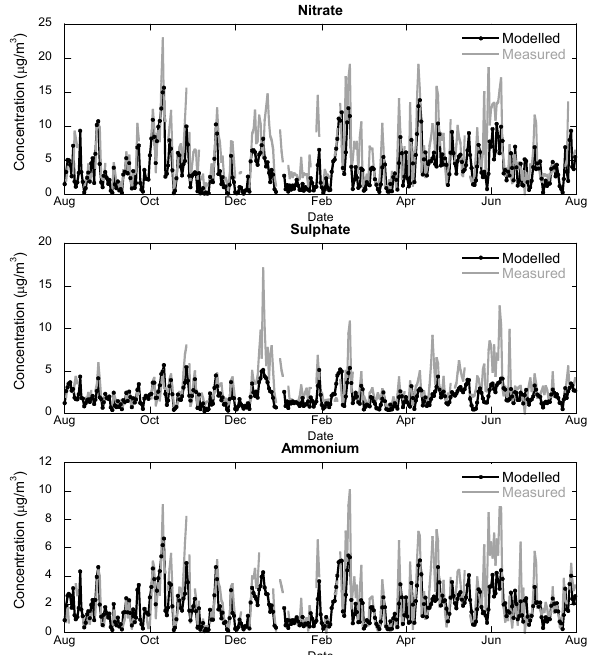
Fig. 4. Comparison of the measured (grey) hourly concentrations of Figure 4. Comparison of the measured (grey) hourly concentrations of nitrate and sulphate at 4 nitrate and sulphate at Cabauw with 7km grid resolution estimates Cabauw with 7 km grid resolution estimates (black) of the LOTOS-EUROS model for Feb-5 (black) of the LOTOS-EUROS model for February-March-April, Mar-Apr, 2008. 6 2008.